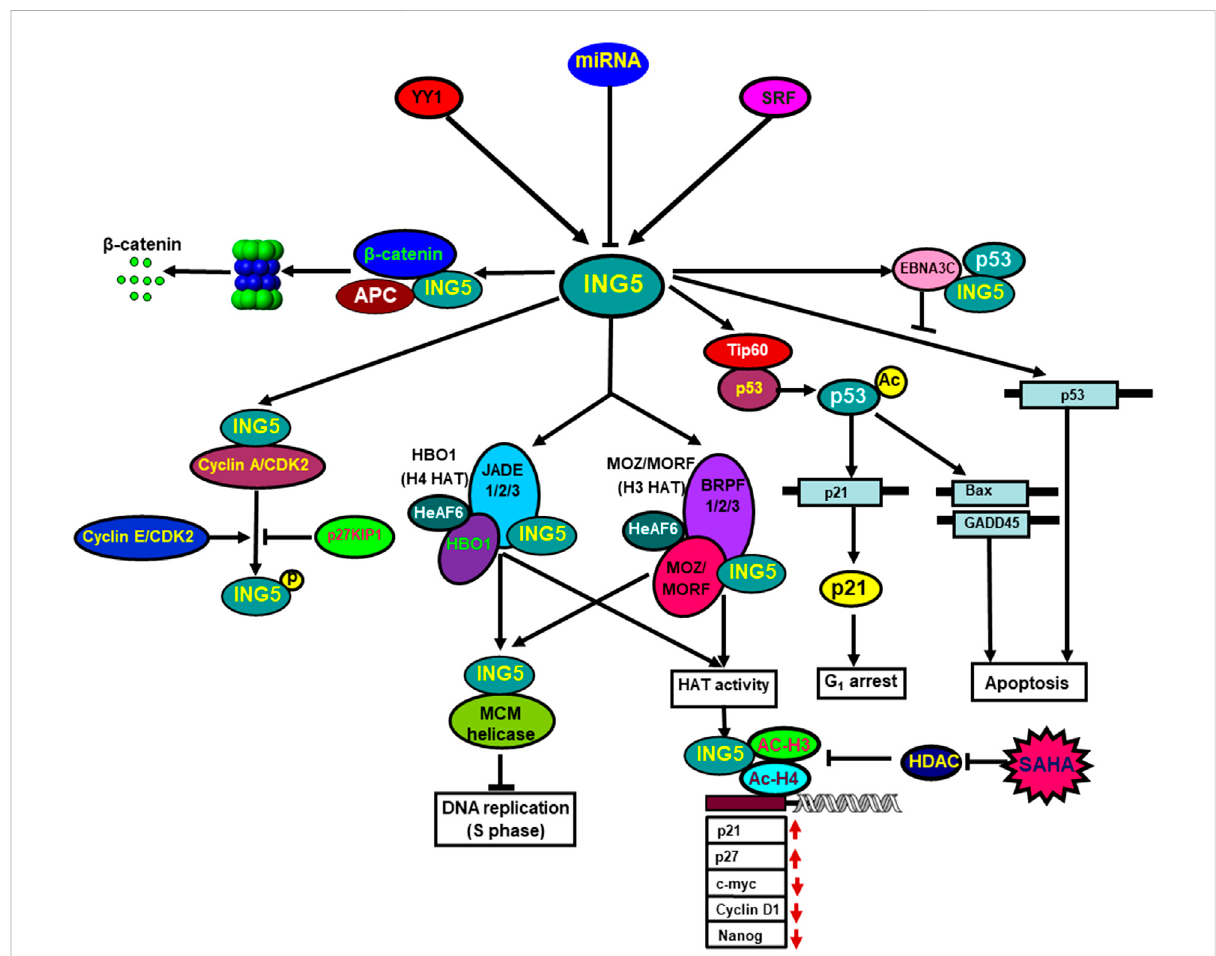
FIGURE 2 The biological functions of ING5. Transcriptionally, YY1 and SRF can up-regulate ING5 mRNA expression by the interaction of YY1-SRF-p53- ING5complexwithING5promoter.Translationally,ING5expressionissuppressedbyassuchmiRNAtargetsasmiR-196a,miR-193a-3p,miR-27-3p, miR-1307, miR-193, miR-222, miR-331-3p, miR-543 and so forth. ING5 interacts with histone H3K4me3 and is involved in the formation of two different HAT (histone acetyltransferase) complexes, (H4-HBO1-JADE-ING5 and H3-MOZ-MORF-BRPF-ING5), which contribute to DNA replication via ING5 and MCM complexes. ING5 binds to Cyclin A1/CDK2, and is phosphorylated by Cyclin E/CDK2 and Cyclin A/CDK2, which is repressed by CDK2 inhibitor p27KIP1. ING5 interacts with Epstain-Barr virus EBNA3C, which suppresses ING5-mediated transcription of p53. Additionally, ING5 assisted Tip60 to acetylate p53, and acetylated p53 at K120 binds to and activates the promoters of Bax and GADD45. ING5 also activates thep21promoter toinducep21 expression via p53 acetylation atLys-382. HAT and SAHAexposure recruitedING5andacetylatedhistones H3 and H4 to the promoters of c-myc, nanog, Cyclin D1, p21, and p27, thereby regulating their